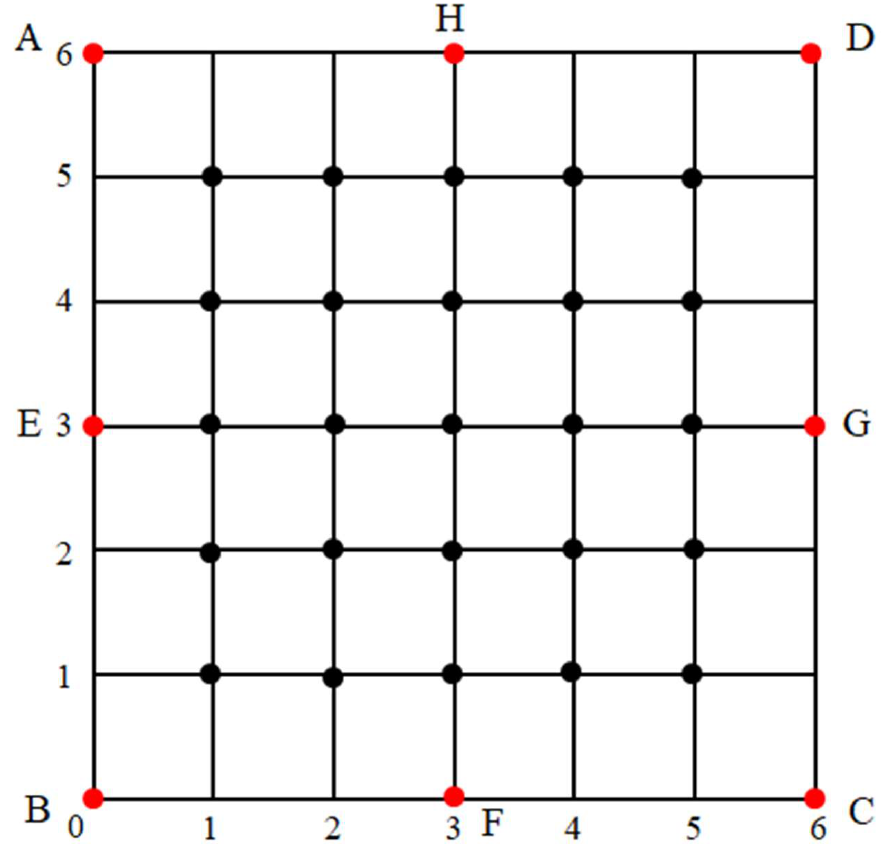
Figure 12. Grid defining the intersection positions and anchor nodes positions.